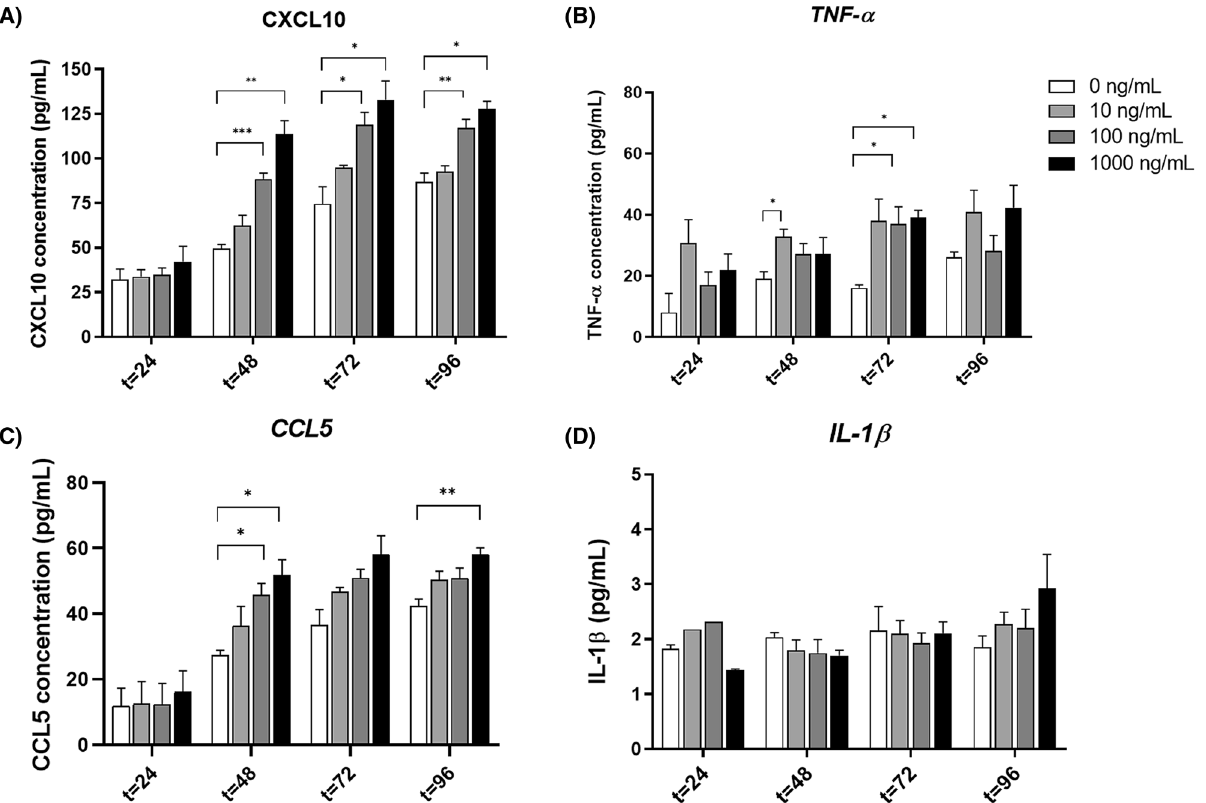
Figure 5. Cytokine and chemokine production in the MTX-induced mucositis organoids. Organoids were treated with 10, 100 and 1000 ng/mL MTX and incubated for 96 h. At different time points supernatant was collected and CXCL10 ( A ), CCL5 ( B ), TNF-α ( C ) and IL-1β ( D ) measured by Multiplex Immunoassay (n = 4). All data are presented as mean ± SEM. * ( p < 0.05), ** ( p < 0.01) and *** ( p < 0.001) represent the significant changes between the MTX-treated and untreated